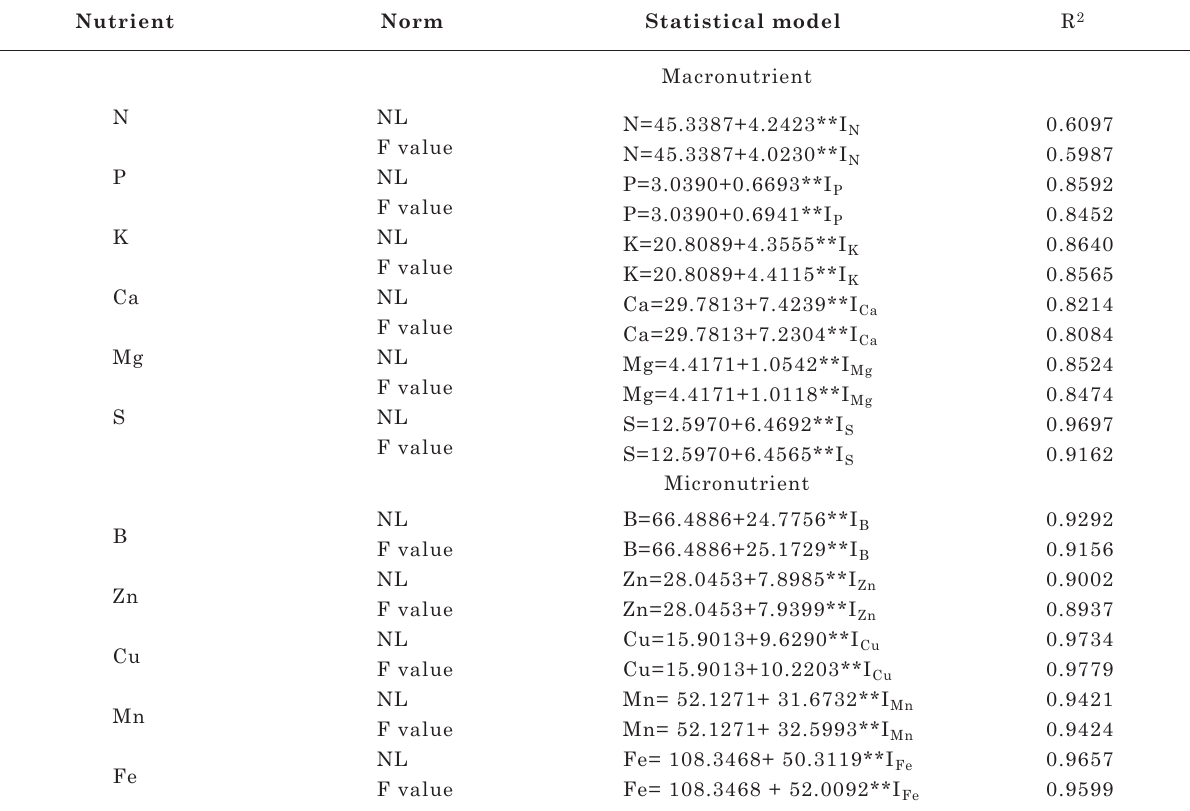
table 2. statistical model of the ratio between macronutrients (g kg -1 ) and micronutrients (mg kg -1 ) and DRis indices. norms were defined by two criteria [natural log transformation (nl) and f value] of data of a reference population